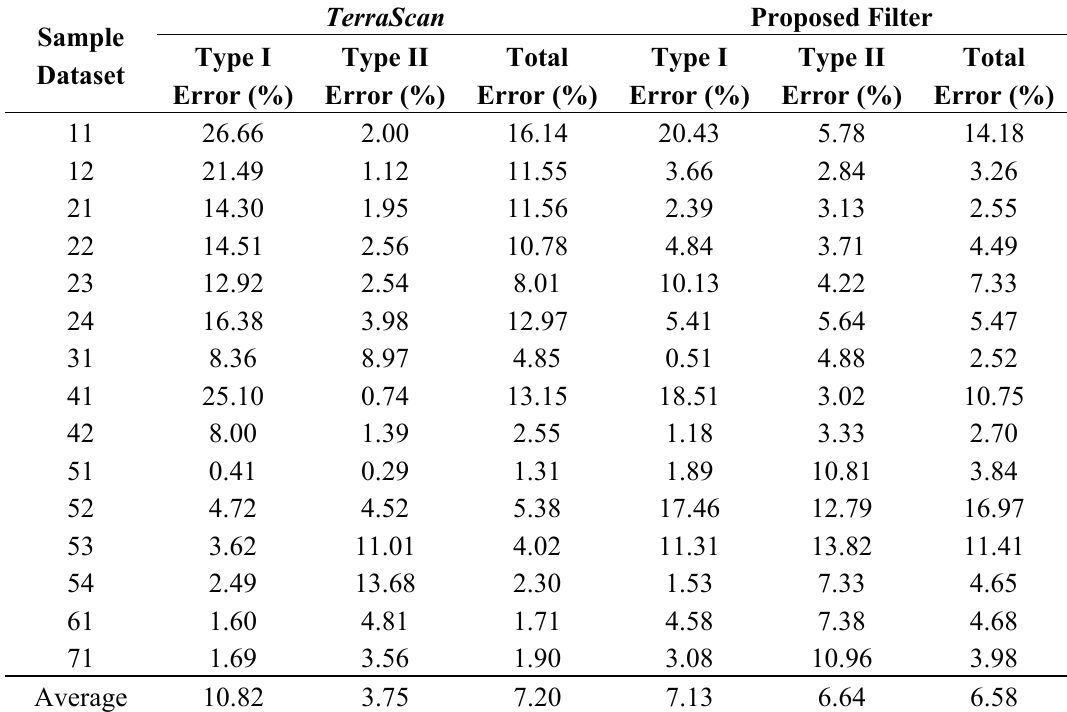
Table 2. Comparison of errors of the proposed filter and TerraScan in filtering the ISPRS sample datasets.